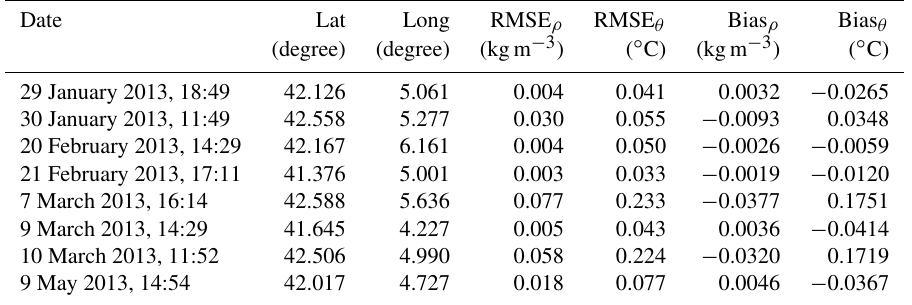
Table 2. RMSE and bias between the averaged observed CTD density and potential temperature profiles and the nearest NEMO control grid point profiles for the respective variables.